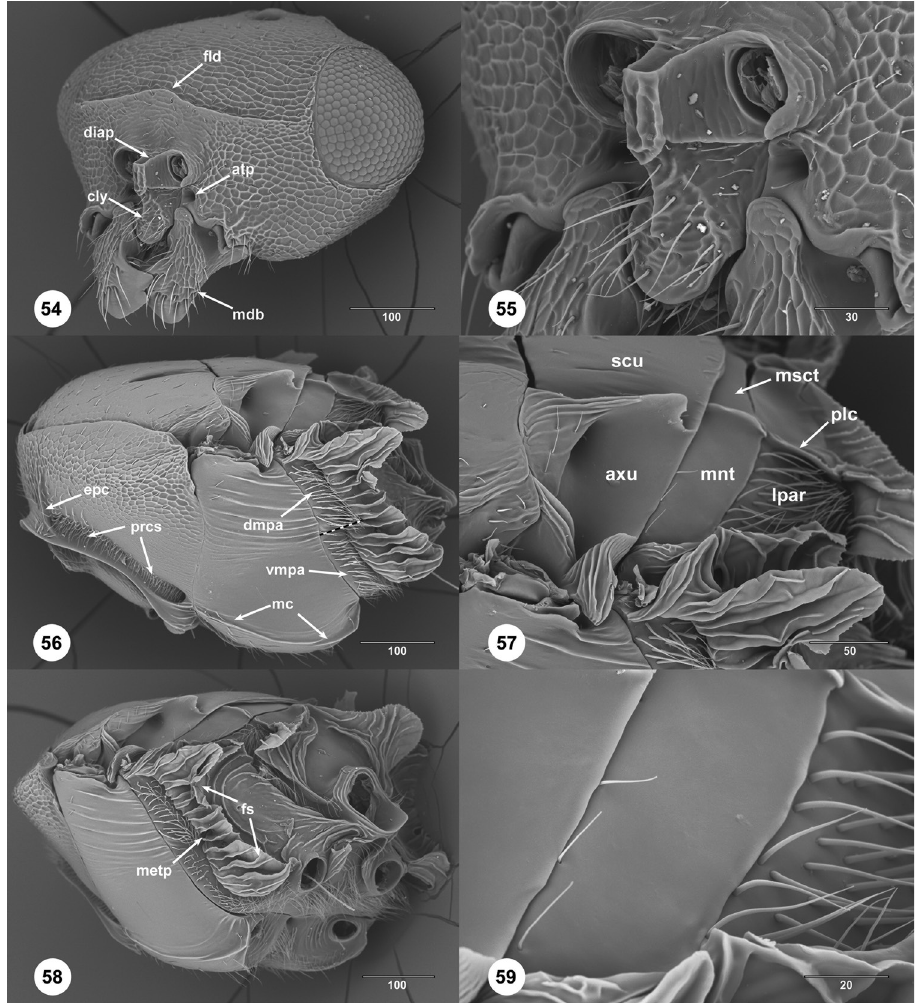
process, clypeus, anterolateral view 56 mesosoma, lateral view 57 axillar complex, metanotum, propo- deum, dorsolateral view 58 mesosoma, posterolateral view 59 metanotal trough, dorsal view. Scale bars in